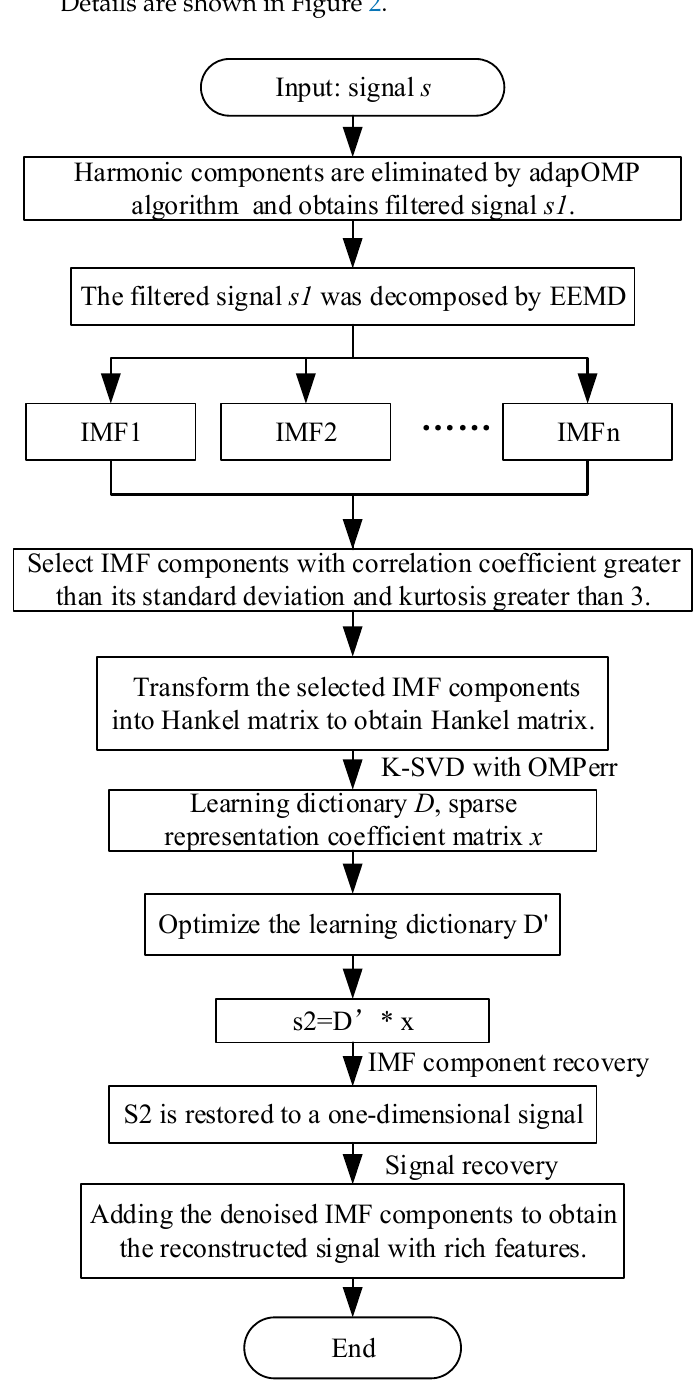
Figure 2. Signal processing flow combining EEMD and sparse representation algorithms.